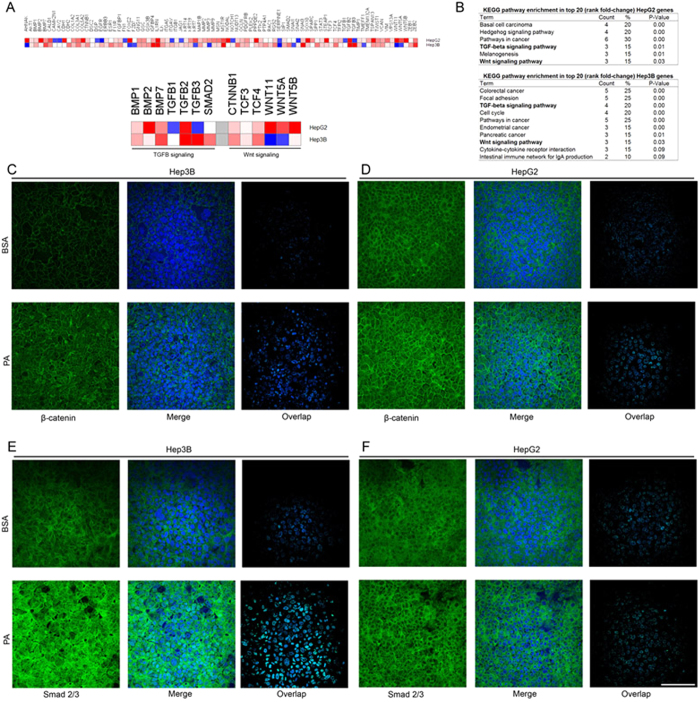
EMT pathways induced by PA.(A) Heatmap showing relative fold-change in mRNA expression levels of various EMT-related genes in PA (0.3 mM) vs. BSA treated cells measured by EMTarray. The enlarged heatmap shows fold change in expression levels of the components of TGFB- and Wnt-signaling pathways included in the array. (B) The top 20 genes ranked according by fold-change in the array were enriched for KEGG pathways. The table shows the term (KEGG pathway) enriched, number and percentage of genes in the input set belonging to the pathway and significance levels of enrichment. (C–F) Confocal images showing expression of β-catenin or SMAD2/3 (green) and nuclei (blue) in HepG2 and Hep3B cells treated with BSA or PA (0.3 mM). The overlap panel shows pixels where both green and blue fluorescence co-localize, therefore indicating cells displaying translocation of β-catenin or SMAD2/3 transcription factors to the nucleus. Images were recorded at 40× with identical exposure and PMT settings maintained between BSA and PA treated cells for a given marker (scale bar = 100 μm).